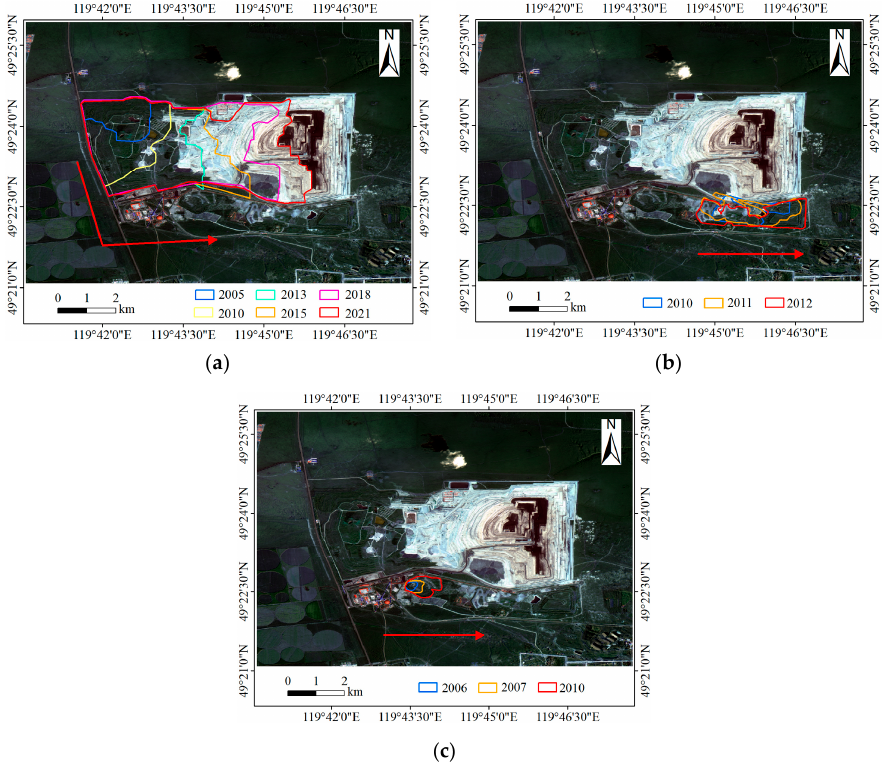
Figure 5. Expansion directions (red arrows). ( a ) North site; ( b ) East site; ( c ) South site.